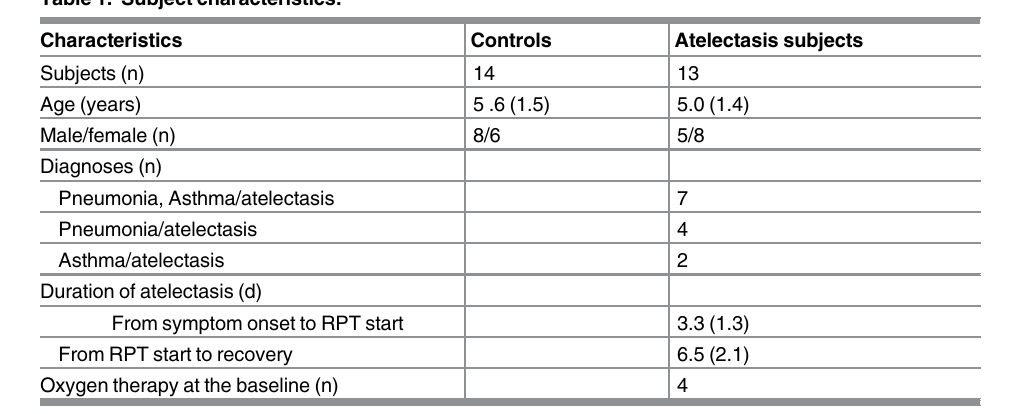
Table 1. Subject